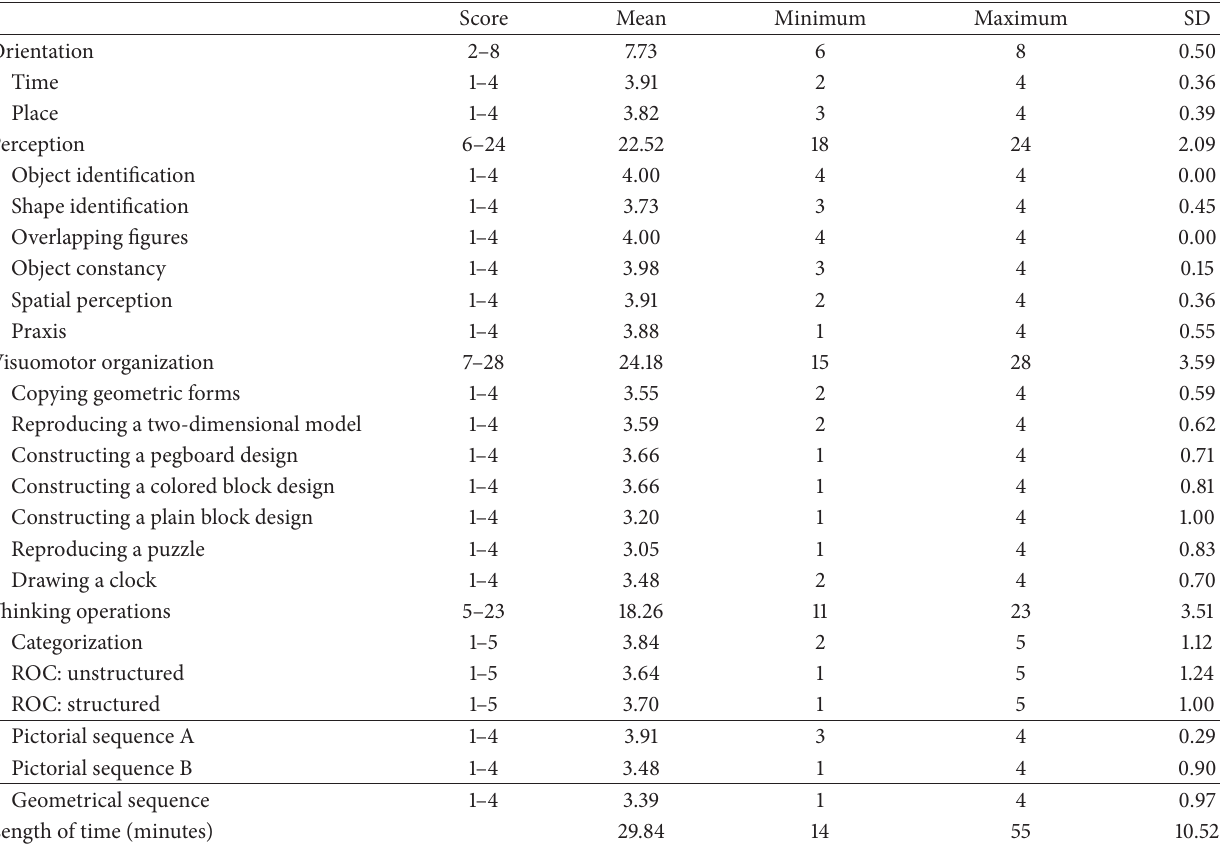
Table 2: Scores obtained on the LOTCA scales and